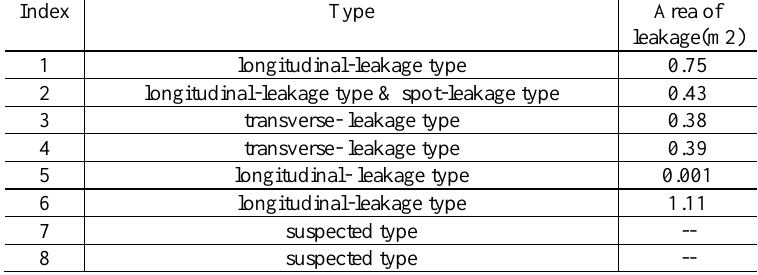
Tab.1 The statistics of the type of seepage and the area of seepage in experiment